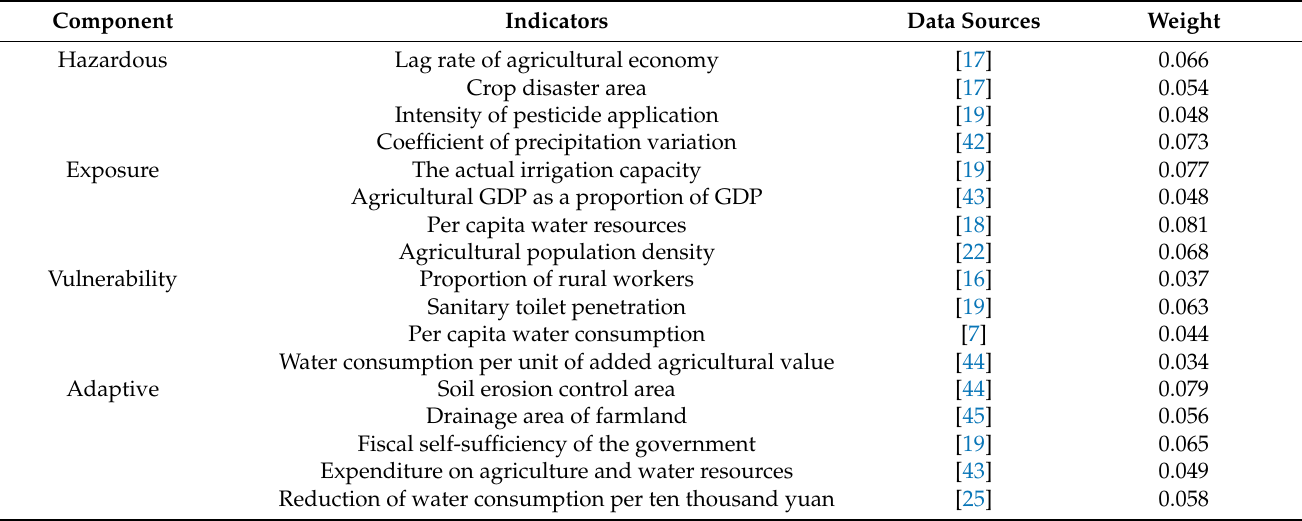
Table 2. Details of the rural water risk components, indicators, and